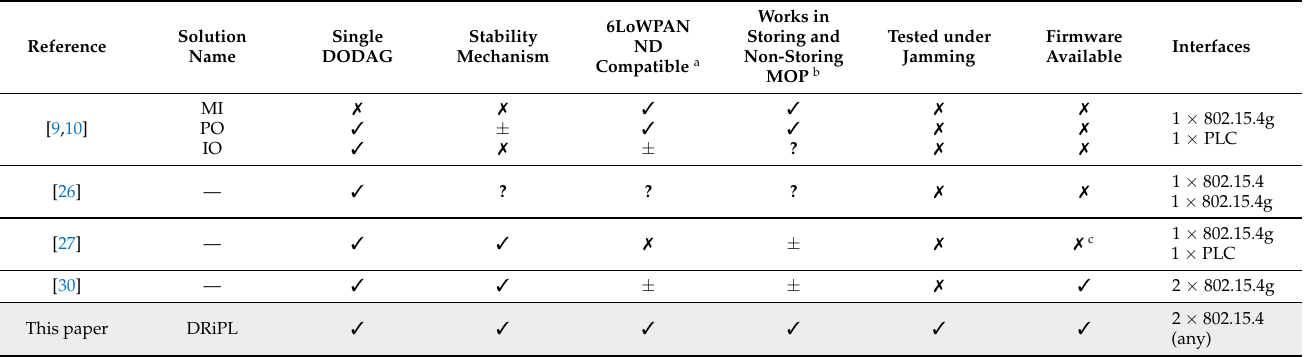
Table 1. Comparison of IPv6 Routing Protocol for Low-Power and Lossy Networks (RPL) solutions that support multiple radio interfaces. Note that an (cid:55) indicates no support, a (cid:51) indicates full support, a ± sign signifies partial support, and a ? means we did not have enough information to determine the kind of support (if